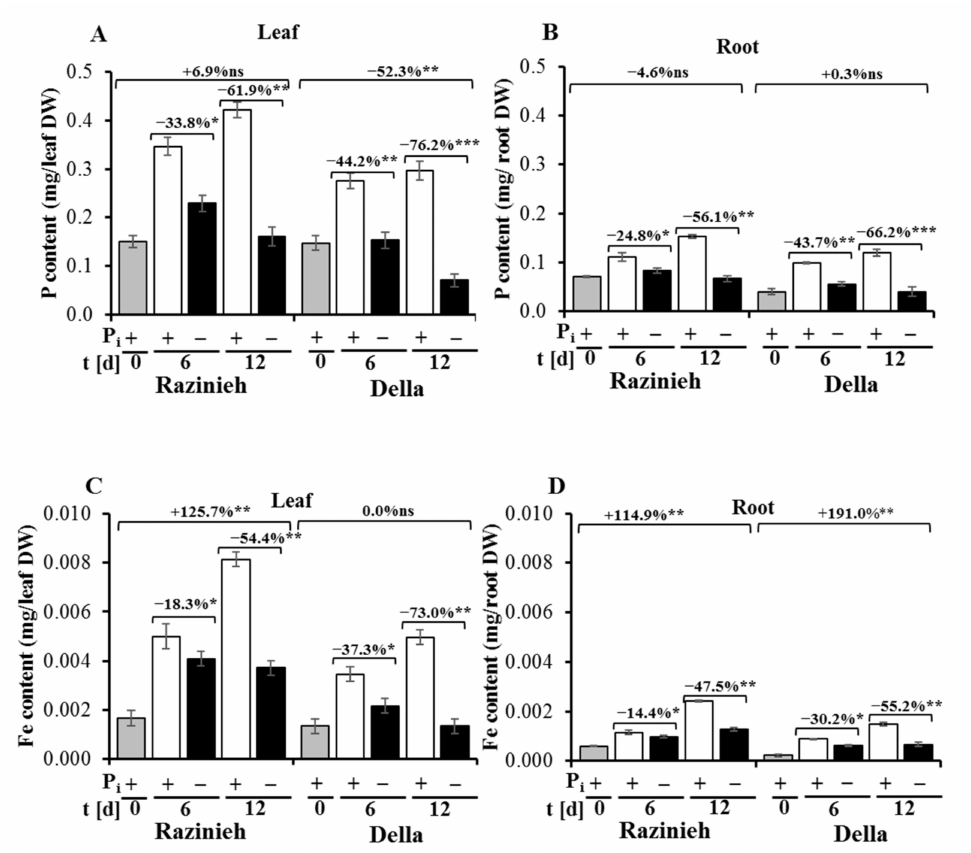
Figure 3. Metal nutrient analysis in the root and shoot of a grain (Razinieh) and a sweet (Della) sorghum variety grown in two varying concentrations of P i hydroponically at the seedling stage. ( A , B ) phosphorus content (mg/g DW) in the leaves and the roots, respectively, and ( C , D ) iron content (mg/g DW) in the leaves and the roots, respectively. The seeds of two varieties were initially grown in agar with 8% MS for 10 days; after that, the seedlings were transferred to half Hoagland solution for 2 days, followed by full Hoagland solution for 4 days to obtain greater adaptation. Thereafter, the seedlings were subjected to 2 mM NH 4 H 2 PO 4 (normal condition; +P i ) or zero (phosphorous starvation; − P i ). After that, plant sampling was conducted at 0, 6, and 12 days of P i starvation for metal nutrient analysis. Values are means ± SE; ns: not significant; *, **, *** are significant at 0.05, 0.01, and 0.001, respectively, paired two-tailed Student’s t -test; n =